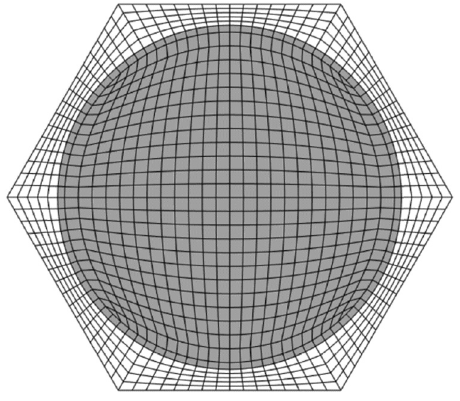
Figure 5: Mesh of a hexagonal unit cell with v 0.72 f = .